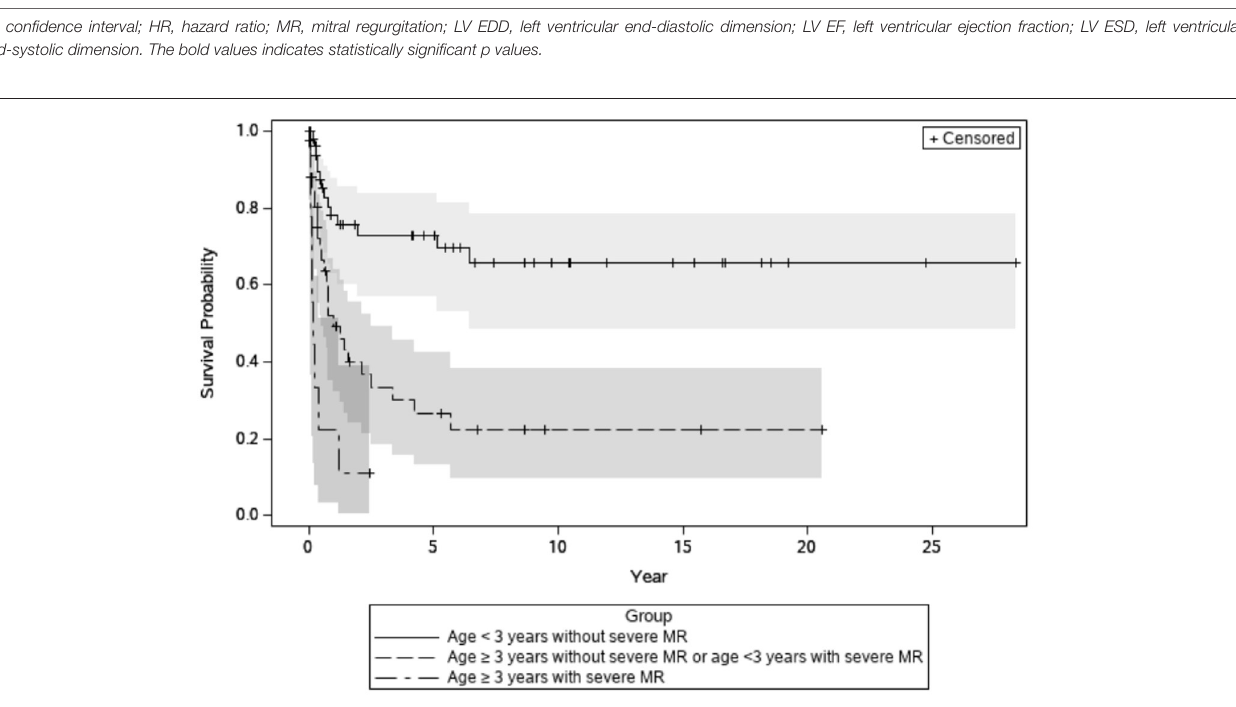
FIGURE 4 | Transplant-free survival stratified by risk factors. Transplant-free survival of those without risk factors, namely severe mitral regurgitation and age at diagnosis ≥ 3 years, was significantly higher than those with one or two risk factors. Both P < 0.001. There was no significant survival difference between those with one risk factor and those with two risk factors, P = 1.00. Gray shaded, 95% confidence